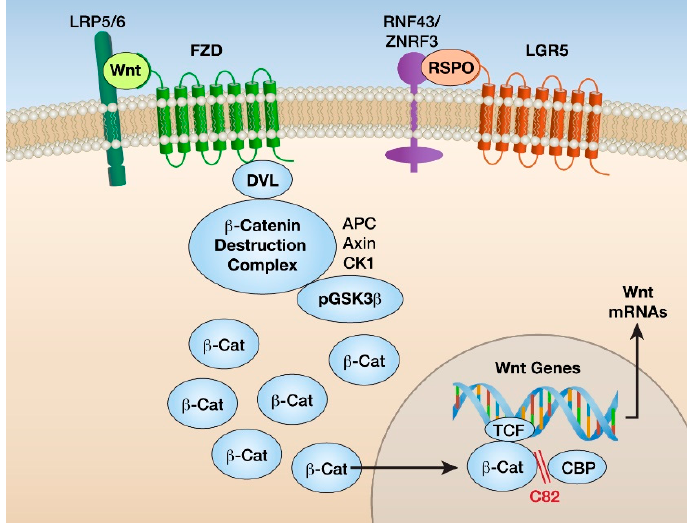
Figure 2. Cartoon of major proteins in the wingless-related integration site (Wnt) / β -catenin growth pathway. Wnt ligands bind frizzled (FZD) and LRP5/6 cell surface receptors. FZD receptors are stabilized by respondin (RSPO) binding to LGR5 and inhibition of ubiquitin E3 ligases (ZNRF43, ZNR43). Intracellularly, the Disheveled (DVL) protein binds to FZD and inhibits the β -catenin destruction complex and CSK3 β , resulting in accumulation of non-phosphorylated β -catenin in the cytoplasm. β -catenin translocates to the nucleus and interacts with the transcription T cell factor (TCF) and the transcription cofactor cyclic AMP-binding protein (CBP). This results in the transcription of Wnt-specific genes. The inhibitor C82, the active form of PRI-724, prevents β -catenin from binding to CBP and inhibits Wnt transcription.